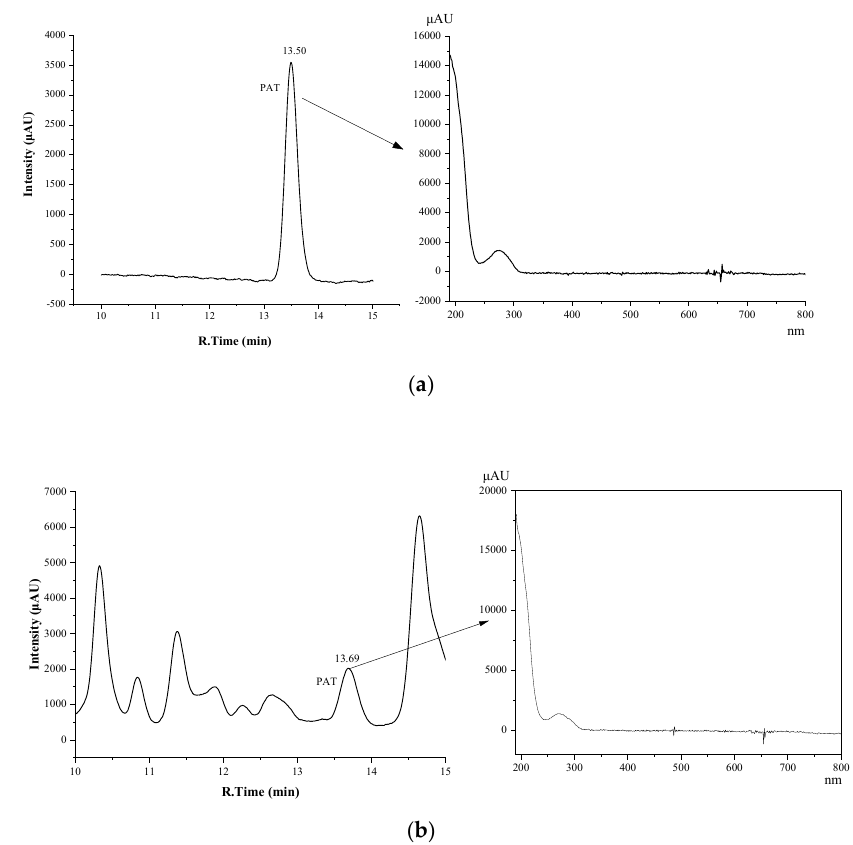
Figure 2. HPLC profiles of different blank teas and spiked teas ( a – g : 50 ng/g; h: 5.0 μg/g). ( a ): green tea; ( b ): Oolong tea; ( c ): yellow tea; ( d ): white tea; ( e ): black tea; ( f ): dark tea; ( g ): Pu-erh tea; ( h ): black tea.